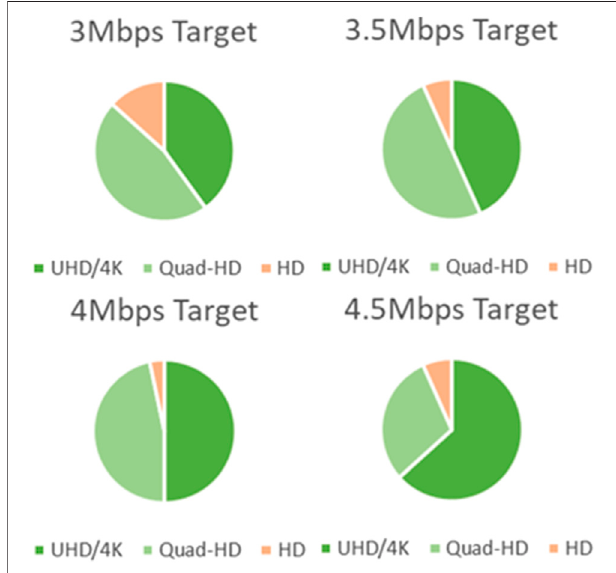
FIGURE 16 | Selected resolution for LCEVC-enhanced streams using the hard-threshold DRE approach